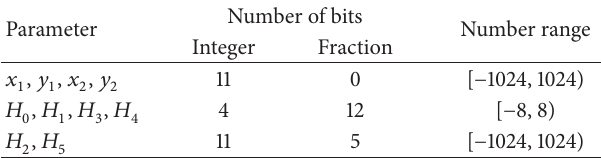
Table 4: Fixed point precision of fitness scoring inputs.